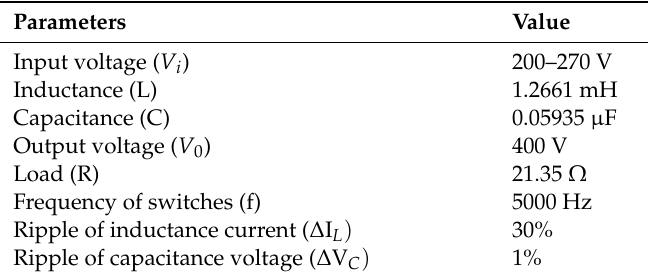
Table 2. DC–DC boost converter